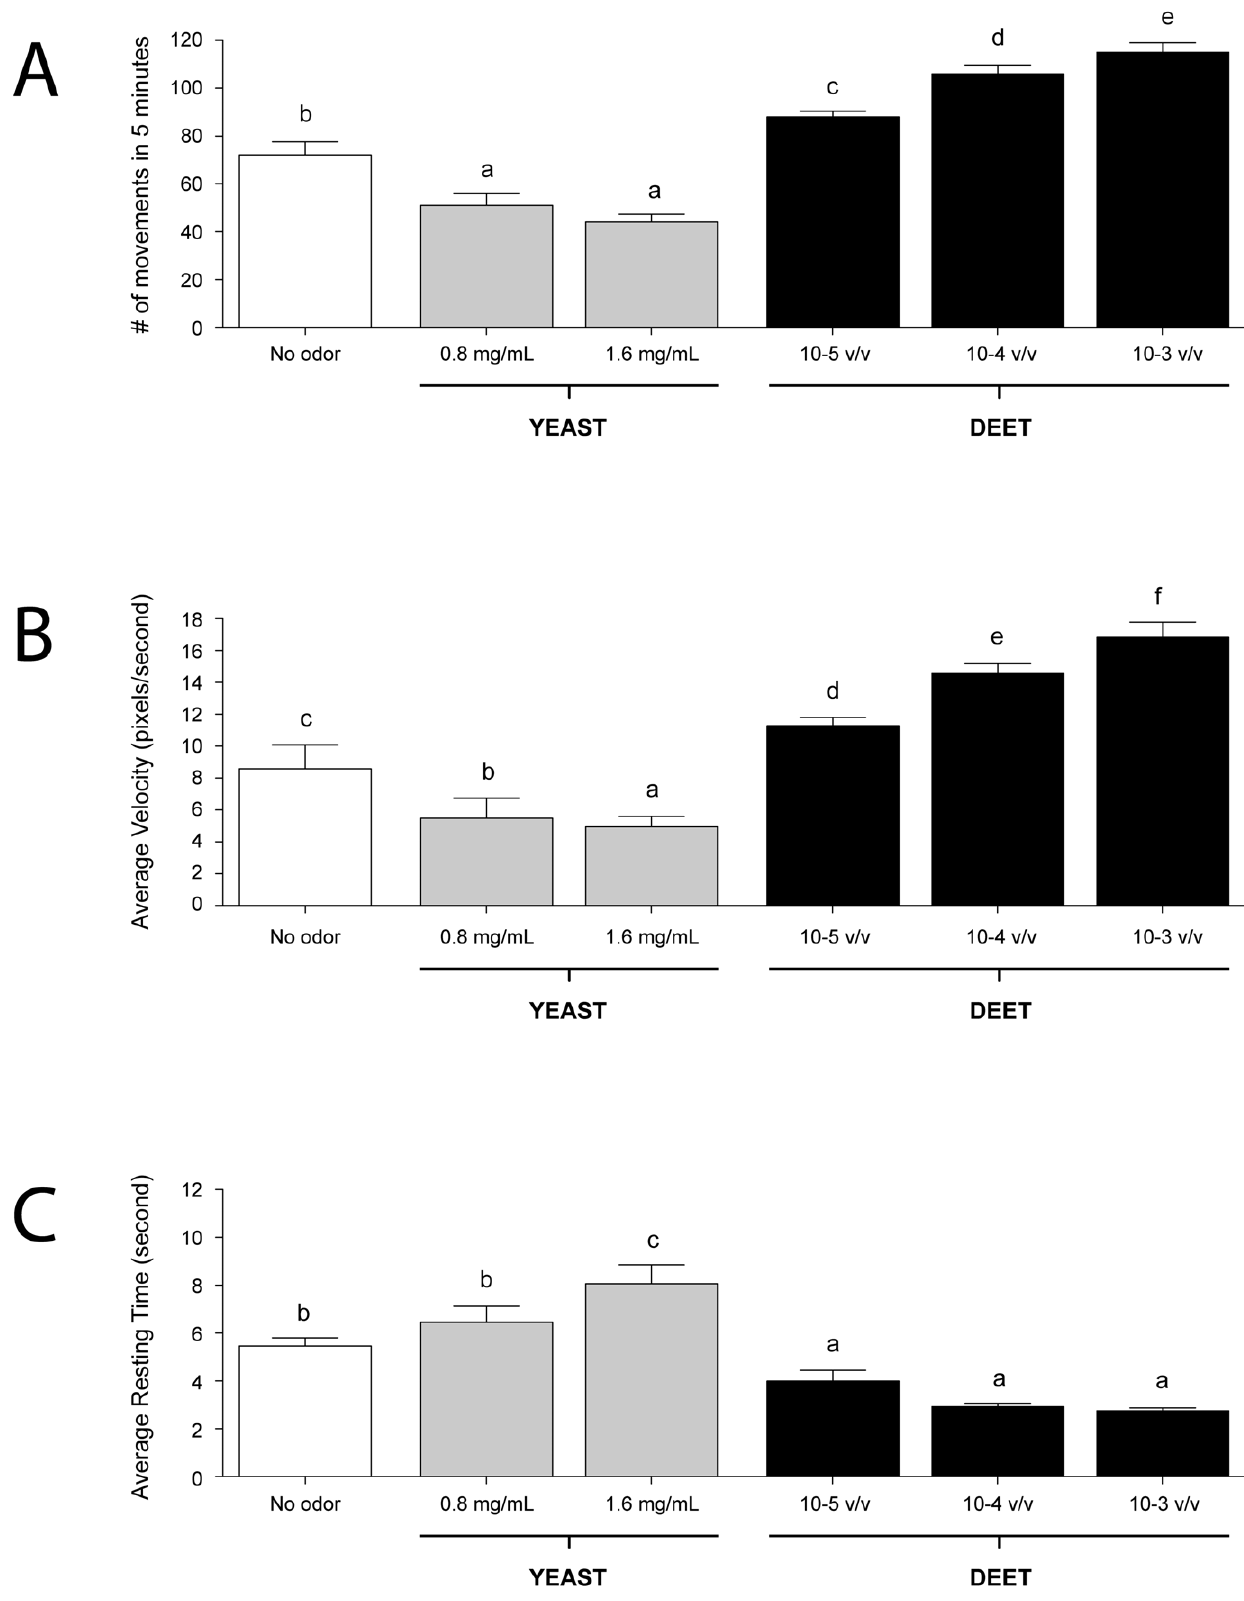
Figure 3. Behavioral effects of yeast and DEET on An.gambiae . Larval responses to yeast and DEET stimuli. Average number of movements (A), velocity (B), and resting time (C)—histograms of larval responses to two concentrations of yeast paste and three concentrations of DEET. Compared with the no-odor control, yeast, and DEET significantly affected larval activity ( p , 0.05). Results are shown as means 6 SE, n =10.